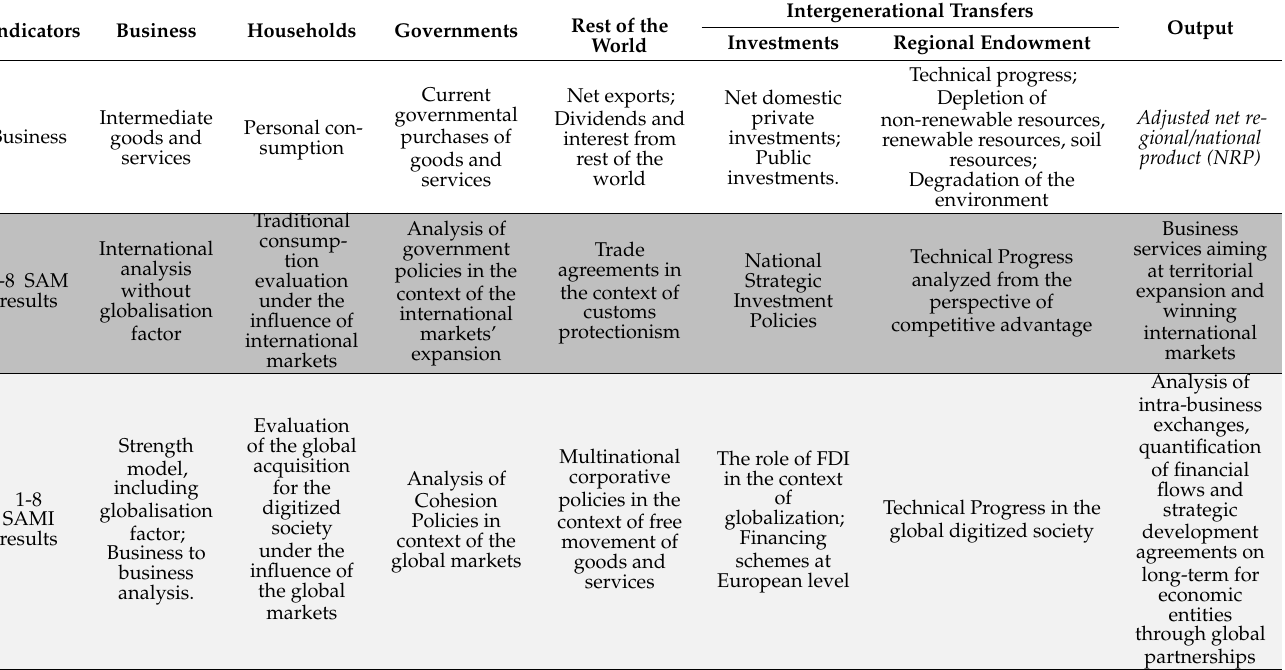
Table 7. SAM vs. SAMI